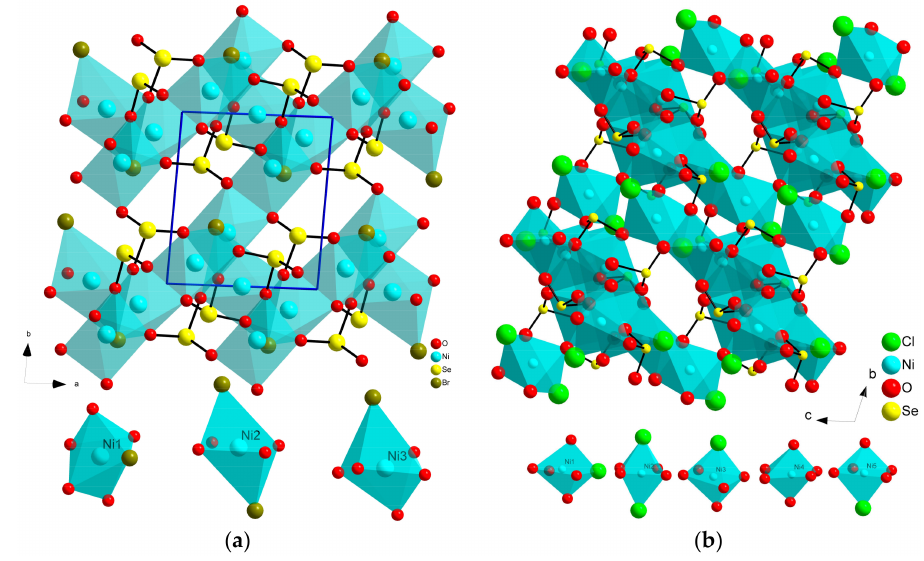
Figure 2. The Ni 5 (SeO 3 ) 4 Br 2 framework crystal structure ( a ) and Ni 5 (SeO 3 ) 4 Cl 2 structure ( b ). Coordination surroundings of the Ni atoms are depicted at the bottom part of the